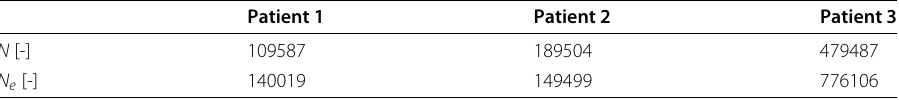
Table 1 Number of degrees of freedom N and number of elements N e for patient-specific computational